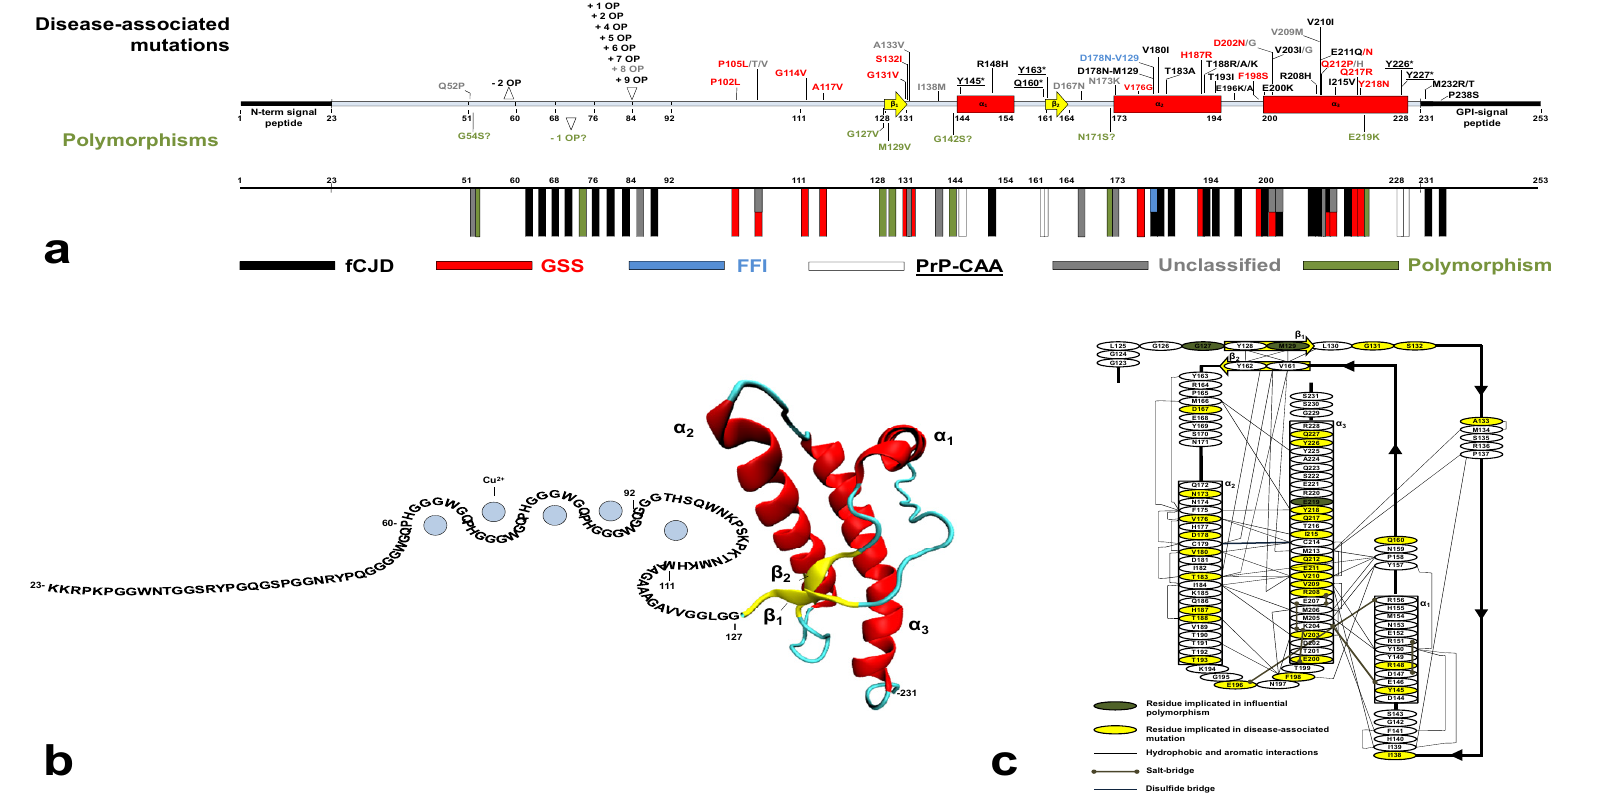
Figure 1. ( a ) Secondary structure of the immature HuPrP with all the currently identified disease-associated mutations and polymorphisms (unclassified phenotype in gray; fCJD in black; GSS in red; PrP-CAA underlined; FFI in blue; and polymorphisms in green). The mature HuPrP consists of residues 23–231, while the N-terminal and C-terminal signal peptides are cleaved during protein maturation. In the lower panel, the frequency of the mutations and polymorphisms along the PRNP sequence is represented by colored rectangles. ( b ) Cartoon of the full-length HuPrP with the sequence-based representation of the disordered N-terminus and the structured C-terminal domain from PDB code 2LSB [28]. Up to four Cu 2+ ions are bound to the OR (residues 60–92) and one Cu 2+ ions is bound to the non-OR (residues 93–111). ( c ) Schematic representation of the secondary elements in the C-terminal HuPrP structured domain. The stabilizing long-range interactions were inferred from structural analysis and published data [31–33]. Residues involved in disease-influential mutations or polymorphisms are